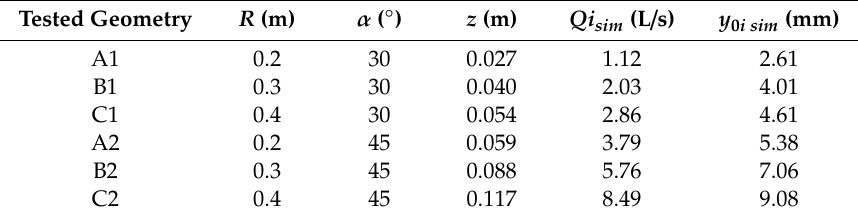
Table 7. Results of flow rate for the initiation of the jet flow Qi sim and flow depth y 0 i sim at the lowest point, obtained with numerical simulation for each geometrical configuration.